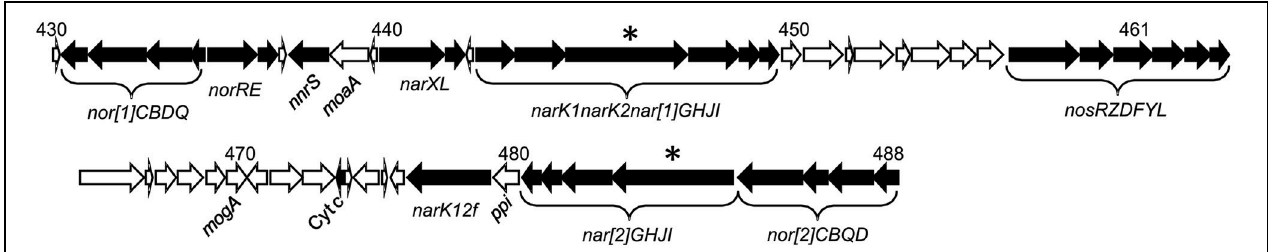
FIGURE 1 | Gene arrangement of the 67 kbp region containing all of the denitrification genes. Sequences and annotations are from GenBank accession number CP003390.2. The numbers above the gene arrangement are the tag locus numbers (Q7A_0430 to Q7A_488). ∗ The corresponding narG that were mutated to derive the knockout mutants. See Supplementary Table S3 for the description of the 58 genes and the relative level of transcript reads.